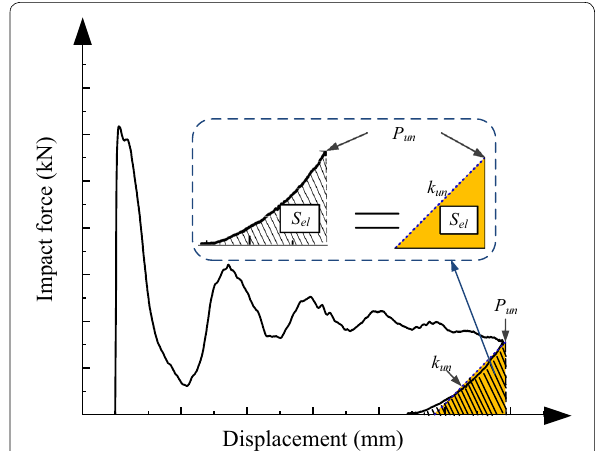
Fig. 9 Typical impact force–displacement curve of axially-loaded RC circular column